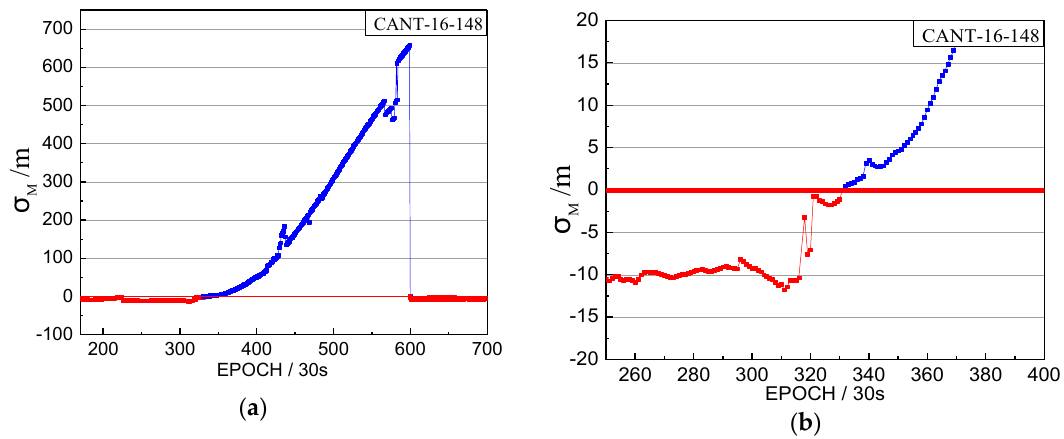
Figure 15. The time factors of the orbital maneuver for CANT station on 27 May 2016. ( a ) The normal vertical axis scale showing overall information; ( b ) The amplified vertical axis scale showing more detailed information.